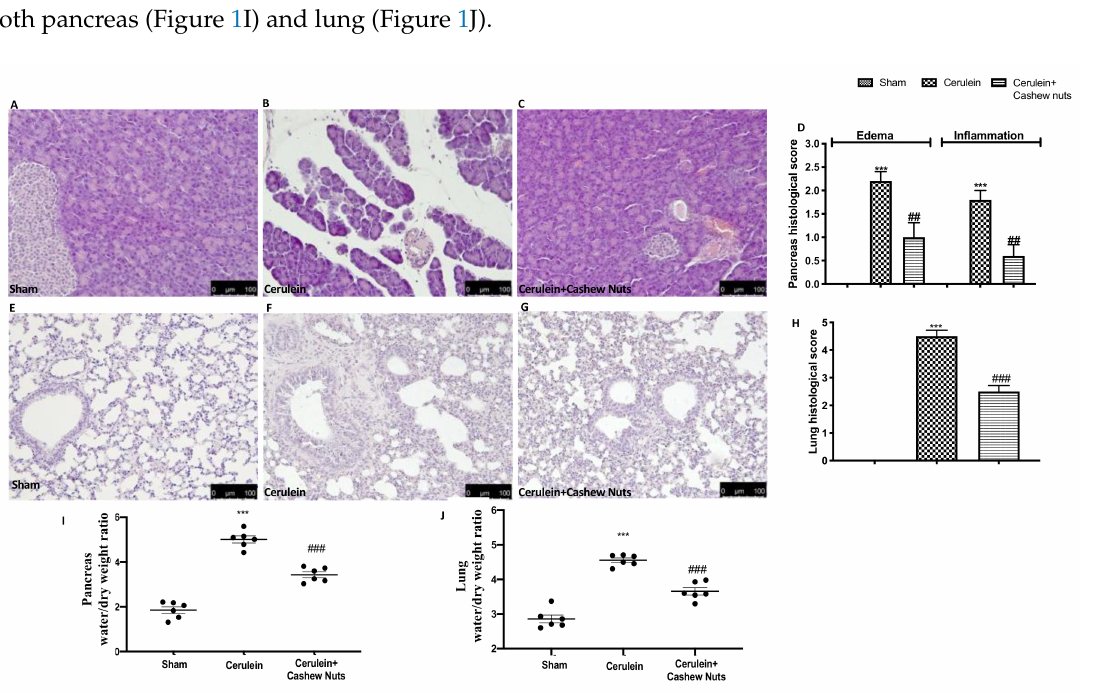
Figure 1. Evaluation of histological damage and oedema in the pancreas and lung of mice with cerulein-induced acute pancreatitis (AP). Pancreas: ( A ) sham, ( B ) cerulein, ( C ) cerulein + cashew nuts, ( D ) pancreas histological score, ( I ) pancreatic oedema. Lung: ( E ) sham, ( F ) cerulein, ( G ) cerulein + cashew nuts, ( H ) lung histological score, ( J ) lung oedema. Values shown are means ± SEM of 6 mice. *** p < 0.001 vs. sham; ## p < 0.01 vs. cerulein; ### p < 0.001 vs.